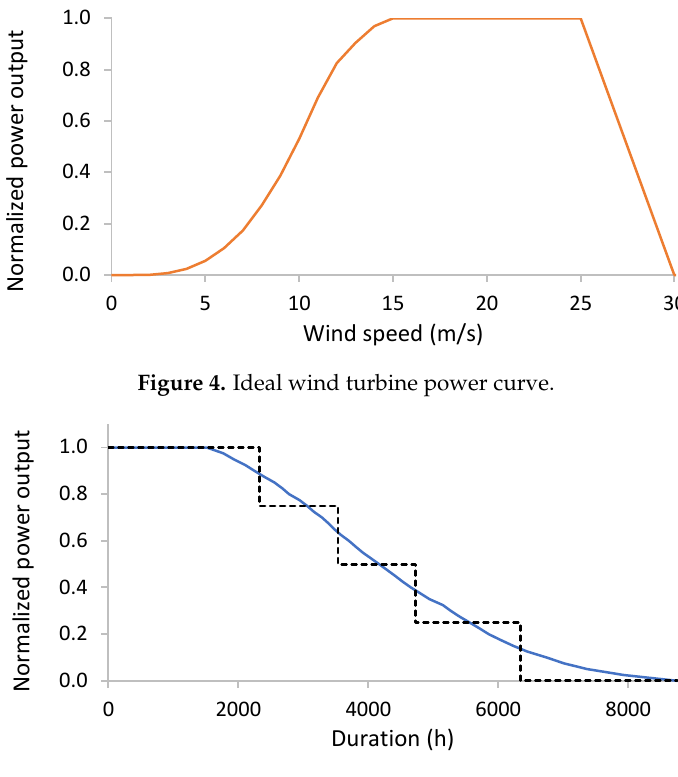
Figure 5. Duration curve for the wind power. The dashed line represents an approximation of the wind power available throughout one year.